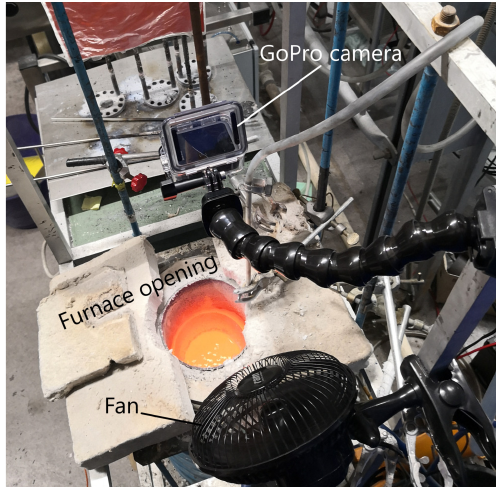
Figure 3. Image of the experimental setup with the camera placed above the surface opening.